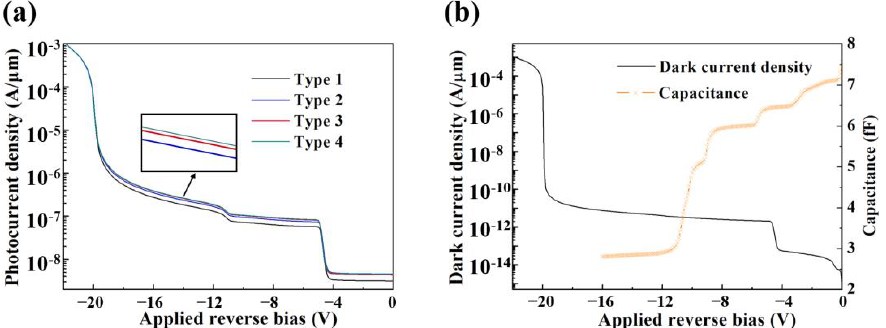
Table 1. Four types of Ge/Si APDs with various structures.